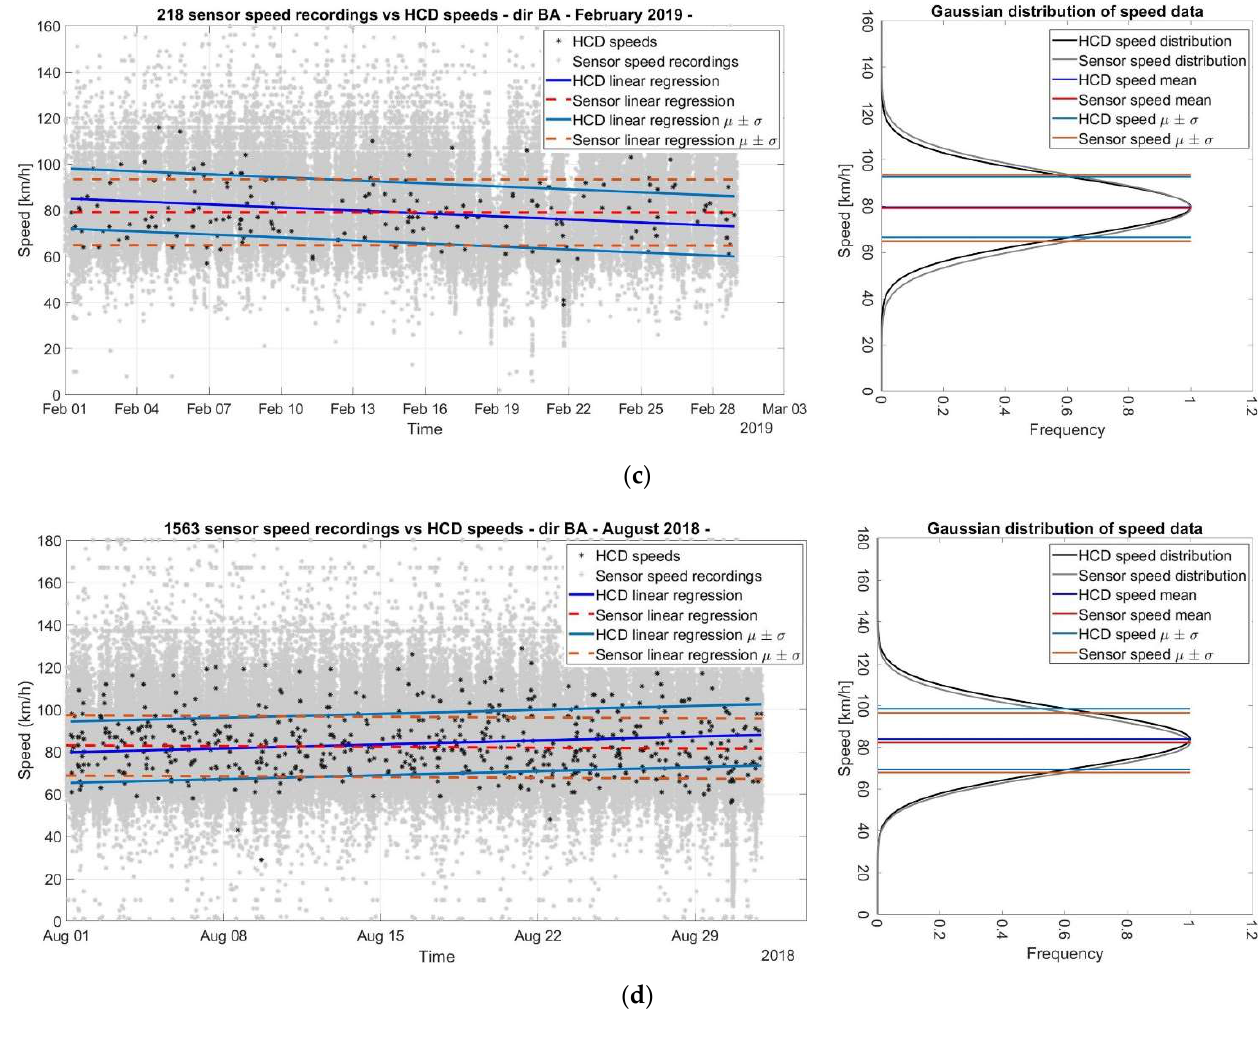
Figure 4. Control units vs. HCD speed samples and linear regressions as a function of time: ( a ) Control unit 1333, AB direction, August 2018; ( b ) Control unit 490, AB direction, February 2019; ( c ) Control unit 218, BA direction, February 2019; ( d ) Control unit 1563, BA direction, August 2018.